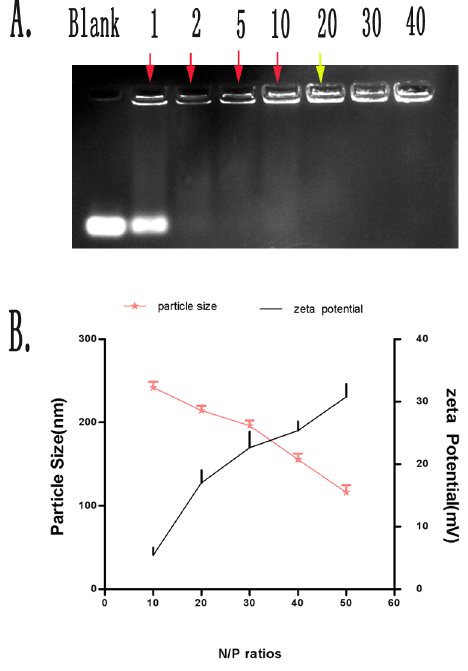
Figure 1. Physical characteristics of siROCK2 complexes. A Investigation of siROCK2 condensation by PEG-PEI through gel retardation assays. SiROCK2 complexes were formed at various N/P ratios (blank, 1, 2, 5, 10, 20, 30, and 40); the concentration of siROCK2 was 100 nM. The red arrows indicate partial condensation of SiROCK2 complexes, whereas the yellow arrow indicates complete condensation of SiROCK2 complexes. B Particle size and zeta potential of siROCK2 complexes formed at different N/P ratios (10, 20, 30, 40, 50, and 70). The data are shown as the means 6 SD; n=3.